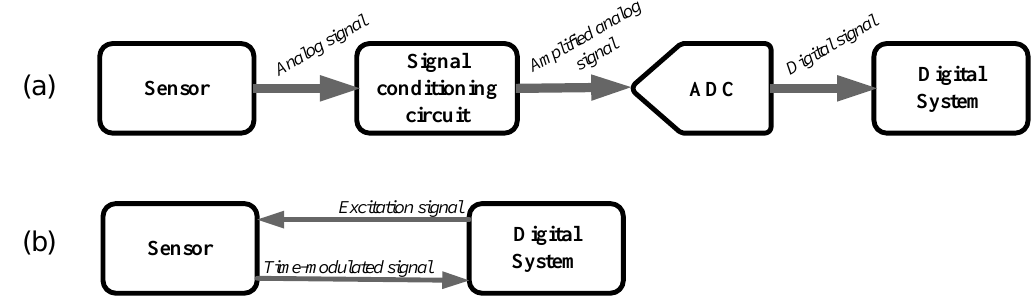
Figure 1. ( a ) Classical block diagram of a sensor electronic interface; ( b ) Direct interface circuit.